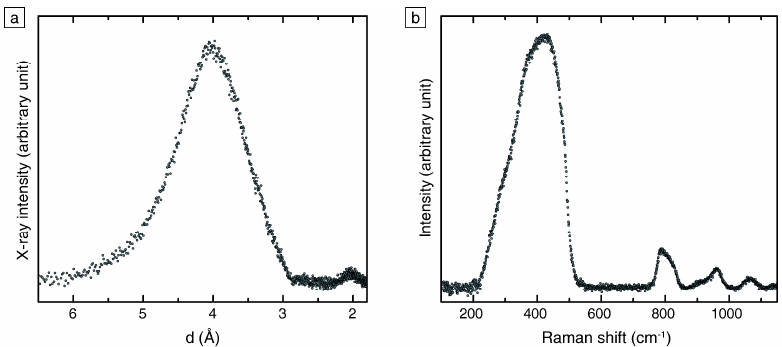
Figure 3. A typical X-ray diffractogram ( a ) and Raman spectrum ( b ) of the studied samples. ( a ) X-ray diffraction patterns (plotted as a function of d-spacing calculated from diffraction angles) generally show a broad asymmetric peak with a maximum ranging between 3.97 and 4.06 Å. A smaller, secondary reflection occurs at ~2 Å. ( b ) The Raman spectra of opals studied here show broad asymmetric bands with a maximum at 425 ± 3, 791 ± 1, and 961 ± 2 cm − 1 , respectively. A more symmetrical band exists at 1067 ± 3 cm − 1 . All spectra are consistent with opal-A [17].